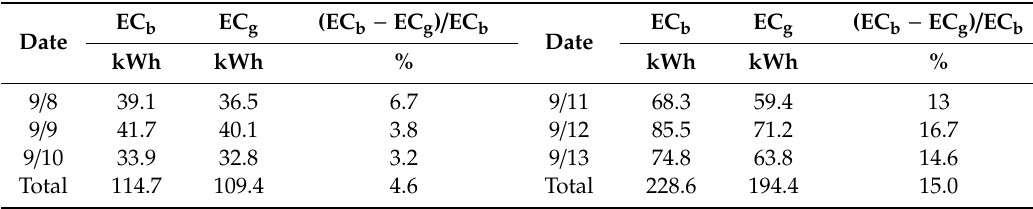
Table 8. Electricity consumption of the air